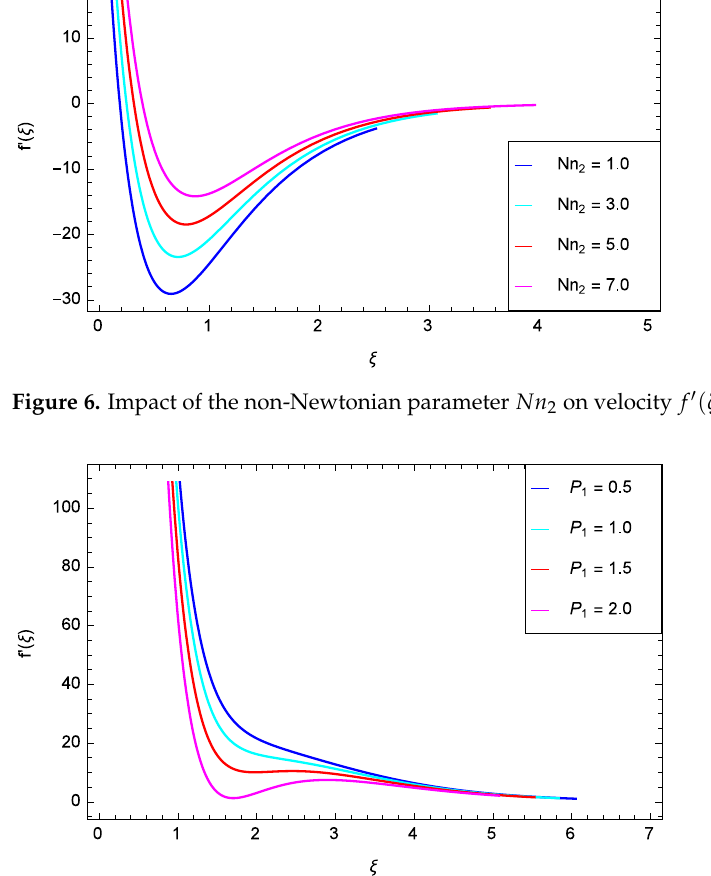
Figure 7. Impact of the porosity parameter P 1 on velocity f (cid:48) ( ζ ) .